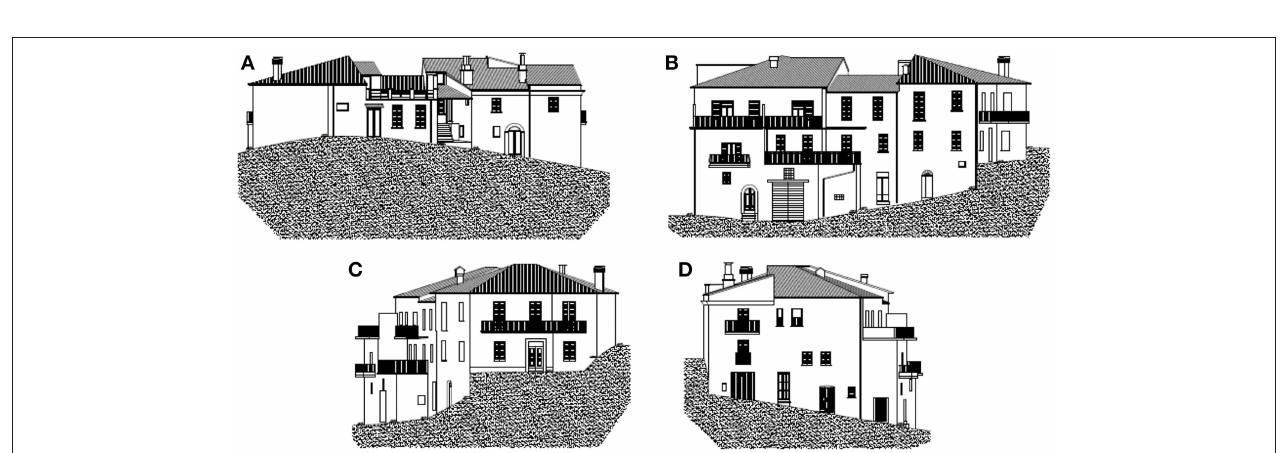
FIGURE 6 | External views of the building cluster under study: north (A) , south (B) , east (C) , and west (D) .